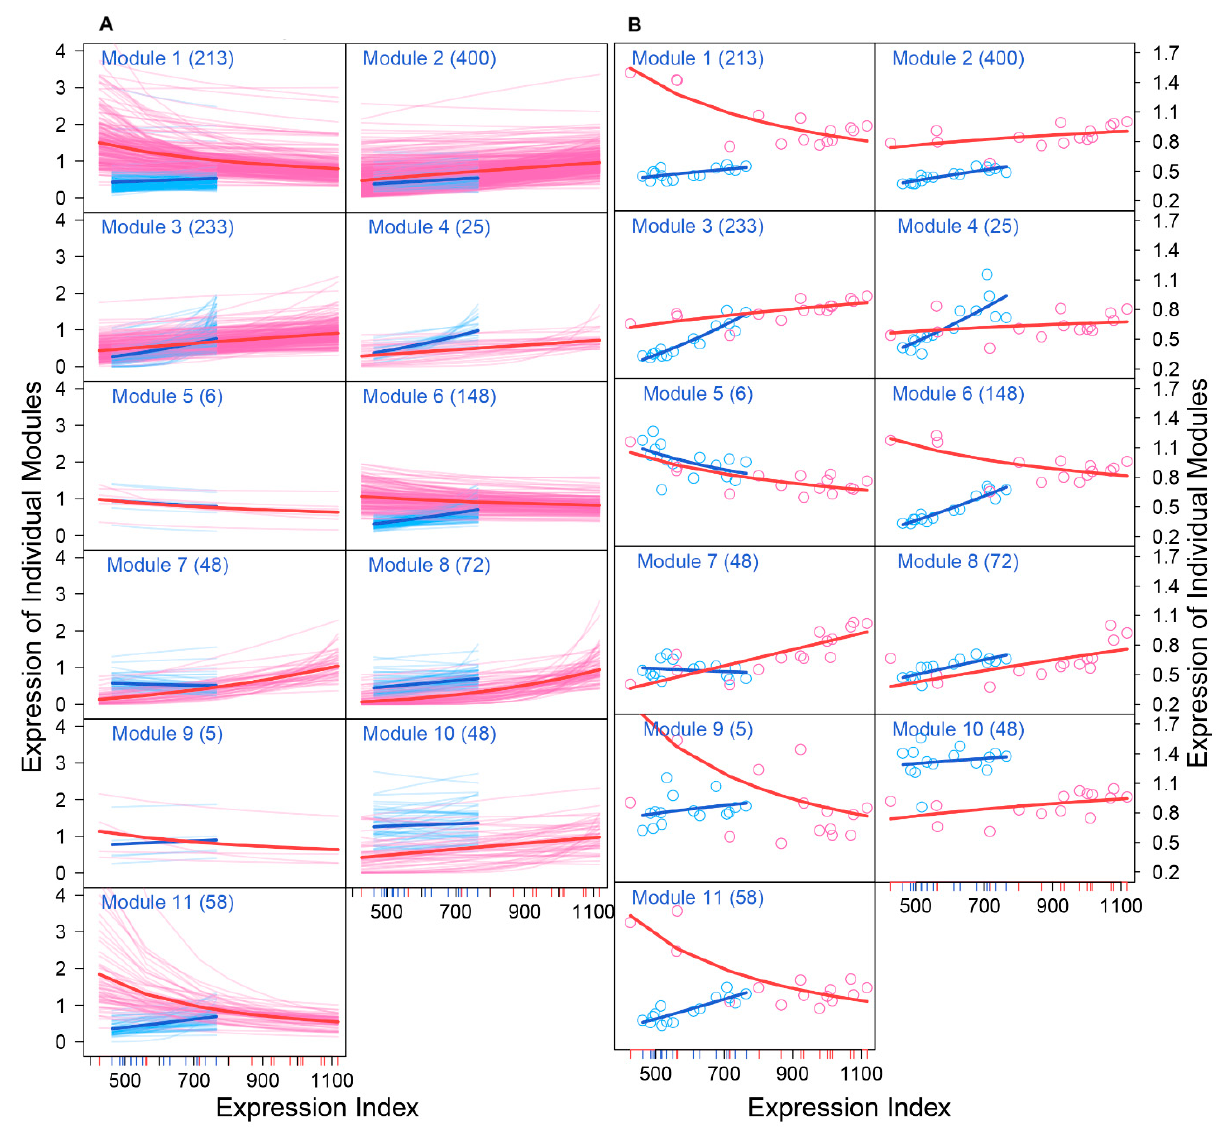
Figure 4. Distinct EI-varying pattern of 11 modules separately for FGCs (blue) and somas (red). ( A ) The change of expression of all genes within a module across EI. Thin lines denote the expression profiles of individual genes and thick lines are the average expression profiles of all genes from each module. ( B ) The fitness of averaged expression values of all genes from each module across EI. Each dot denotes the averaged expression value of genes on each sample.